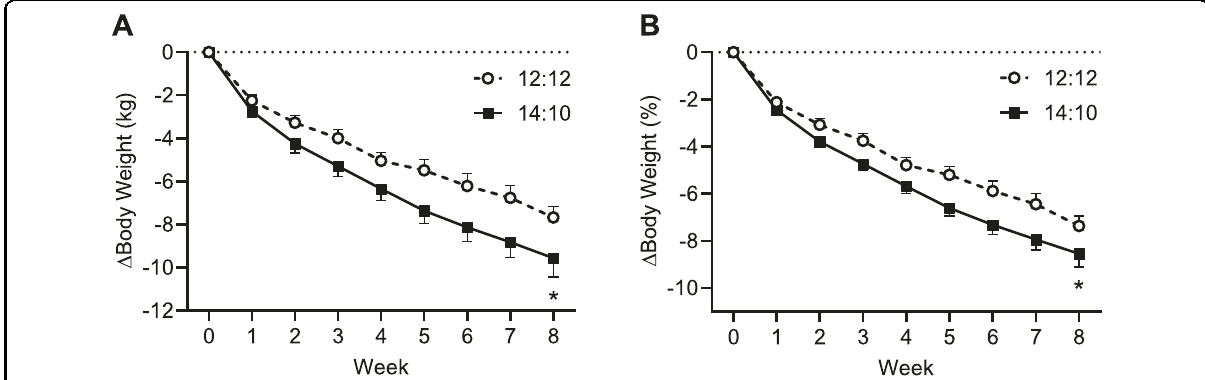
Fig. 2 Change in body weight in study completers. A Change in body weight. B Change in percent body weight. Data are mean ± SE for the completer population ( n = 30). * P < 0.05 for comparison of the adjusted LS mean change from baseline to Week 8 in the 14:10 group compared to the 12:12 group.